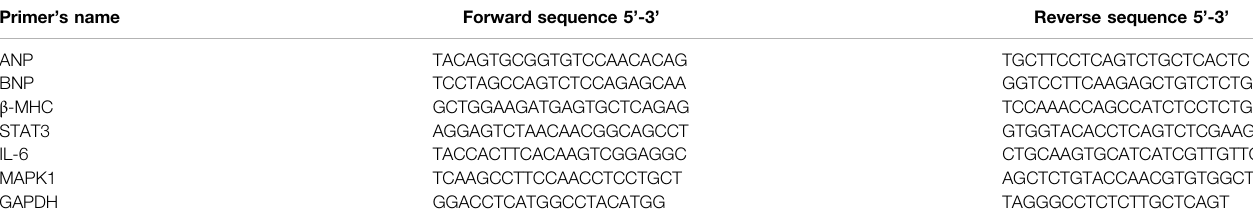
TABLE 1 | The primer sequence for